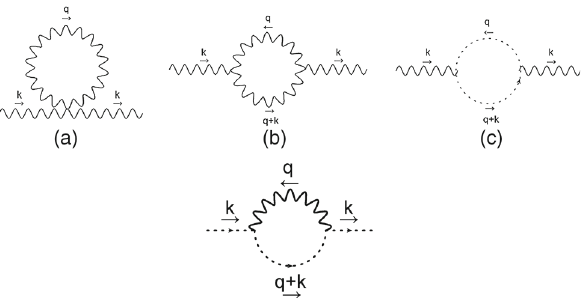
Fig. 2 (top) Gluon vacuum polarization diagrams a – c to one-loop order, (bottom) ghost self-energy diagram to one-loop